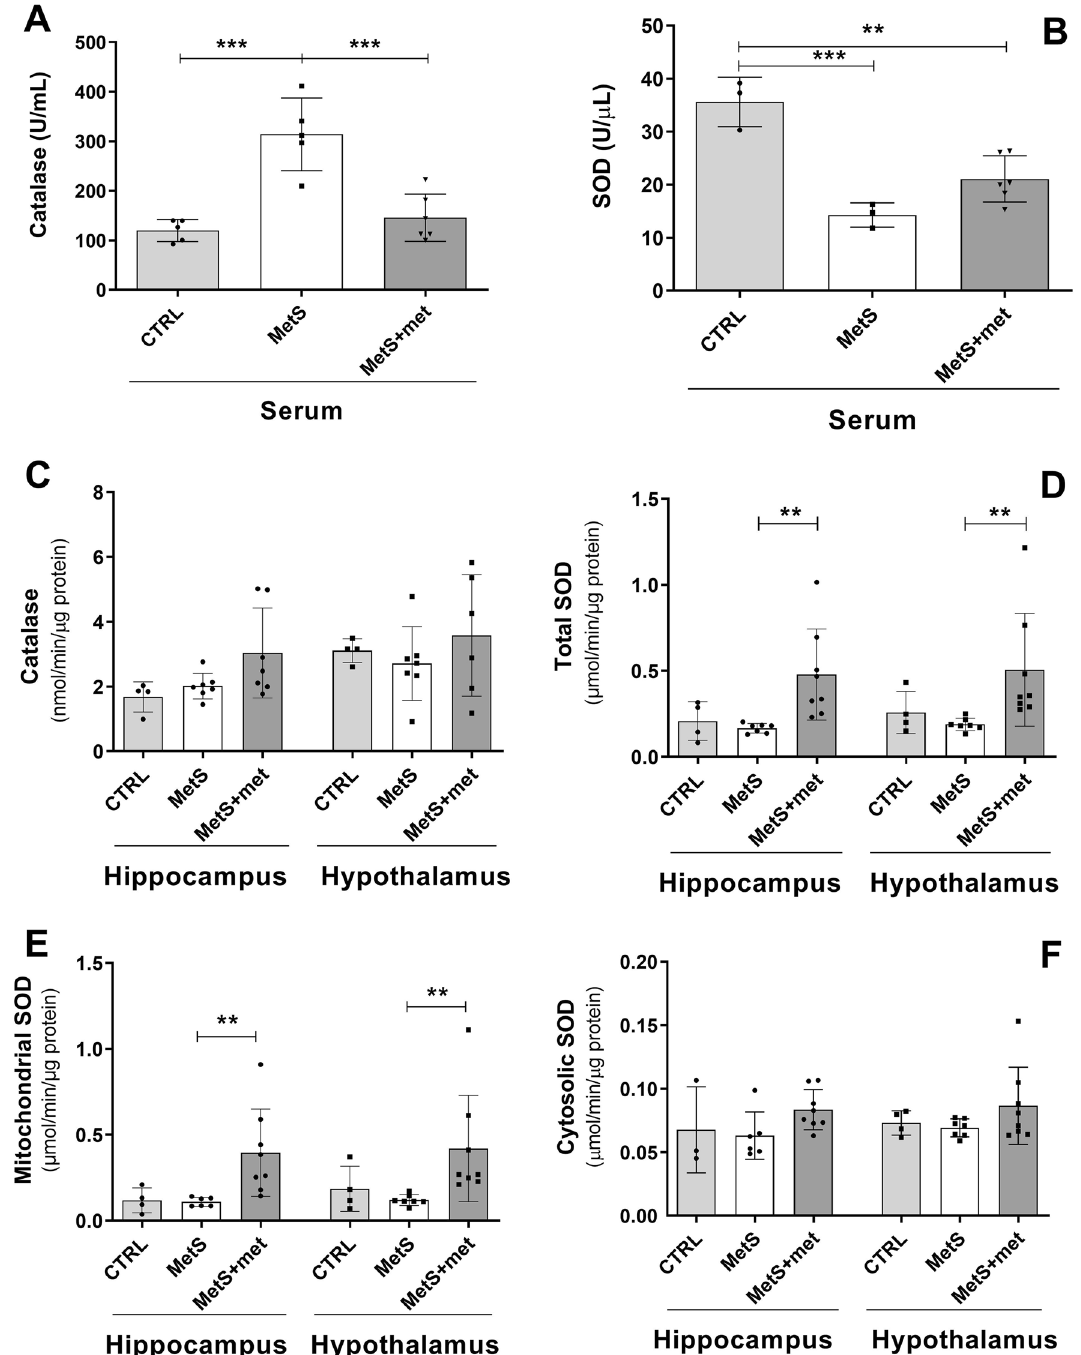
Figure 5. Effect of the metabolic syndrome (MetS) and metformin on antioxidant enzyme activity. ( A , B ) Serum catalase and superoxide dismutase (SOD) activity. ( C ) Brain catalase activity. ( D–F ) Total, mitochondrial and cytosolic SOD activity in the hippocampus and hypothalamus. The data represent the mean ± SD. Sample size (N) serum catalase CTRL = 5, MetS = 5, MetS + met = 6; serum SOD CTRL = 3, MetS = 3, MetS + met = 6; hippocampal catalase CTRL = 4, MetS = 7, MetS + met = 7; hypothalamic catalase CTRL = 4, MetS = 7, MetS + met = 6; total SOD, hypothalamic cytosolic and mitochondrial SOD CTRL = 4, MetS = 7, MetS + met = 8; hippocampal cytosolic SOD CTRL = 3, MetS = 6, MetS + met = 8; hippocampal mitochondrial SOD CTRL = 4, MetS = 6, MetS + met = 8. **p ≤ 0.01, ***p ≤